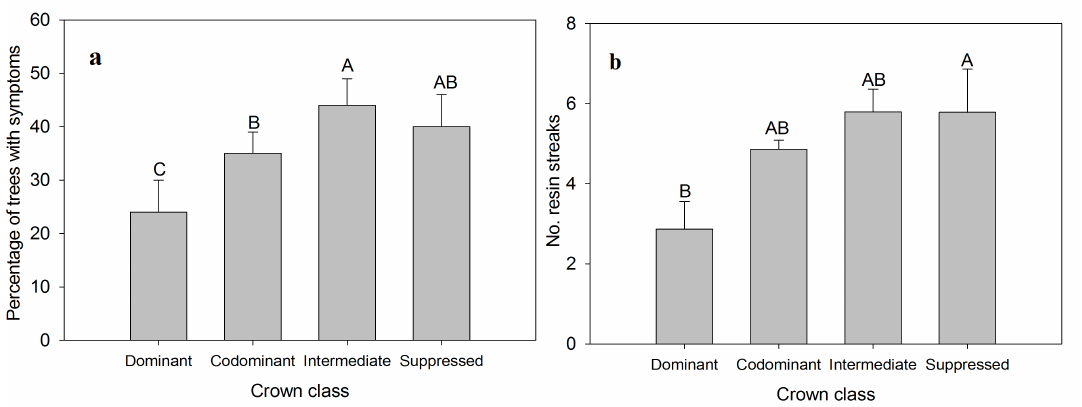
Figure 6. ( a ) Incidence; ( b ) and severity of Caliciopsis canker symptoms in relation to crown class. Bars represent means and standard errors. Values with the same letter are not statistically different (α = 0.05)